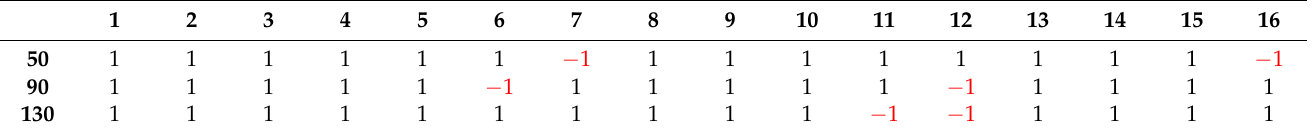
Table 8. The level of cognitive load based on saccade frequency: T ≥ B → 1; T < B → –1